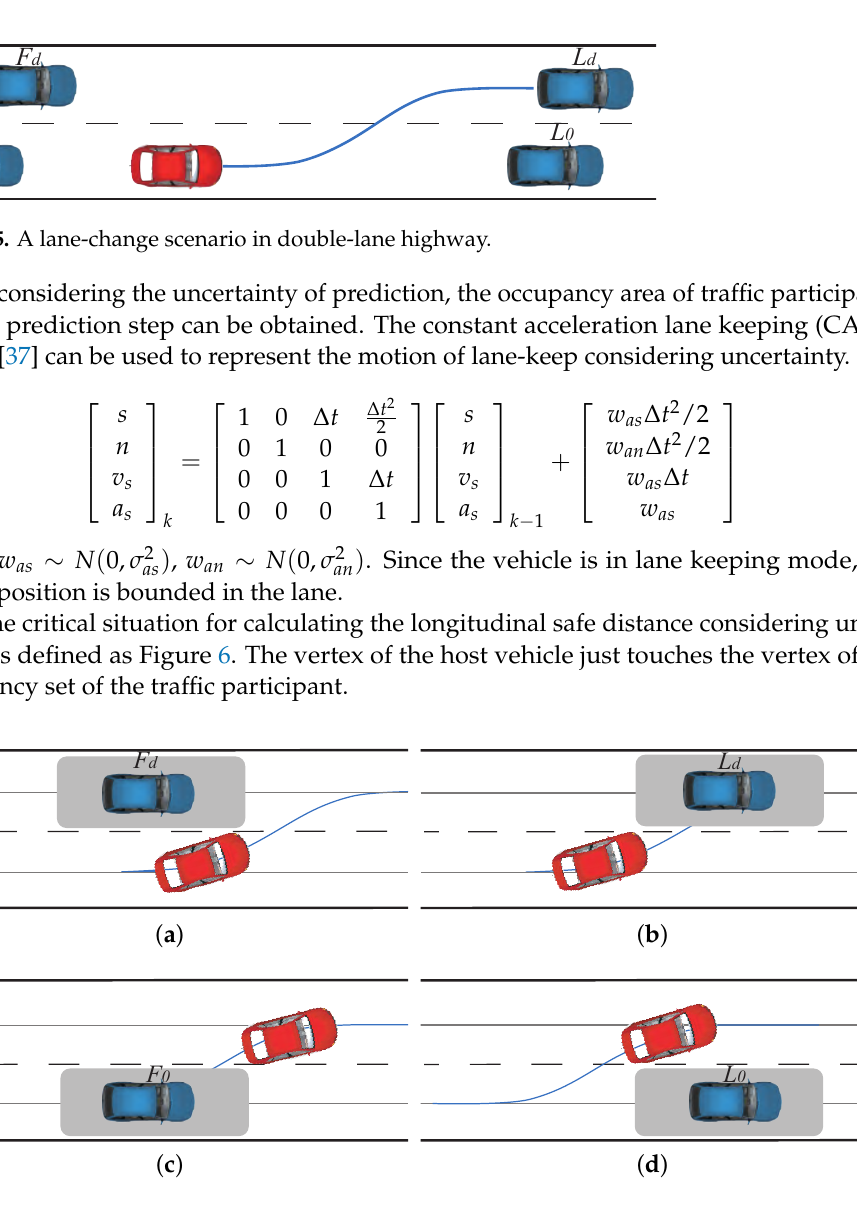
Figure 6. The critical situations for lane-change considering uncertainty of prediction. ( a ) The critical situation for F d at t c , Fd . ( b ) The critical situation for L d at t c , Ld . ( c ) The critical situation for F 0 at t c , F 0 . ( d ) The critical situation for L 0 at t c , L 0